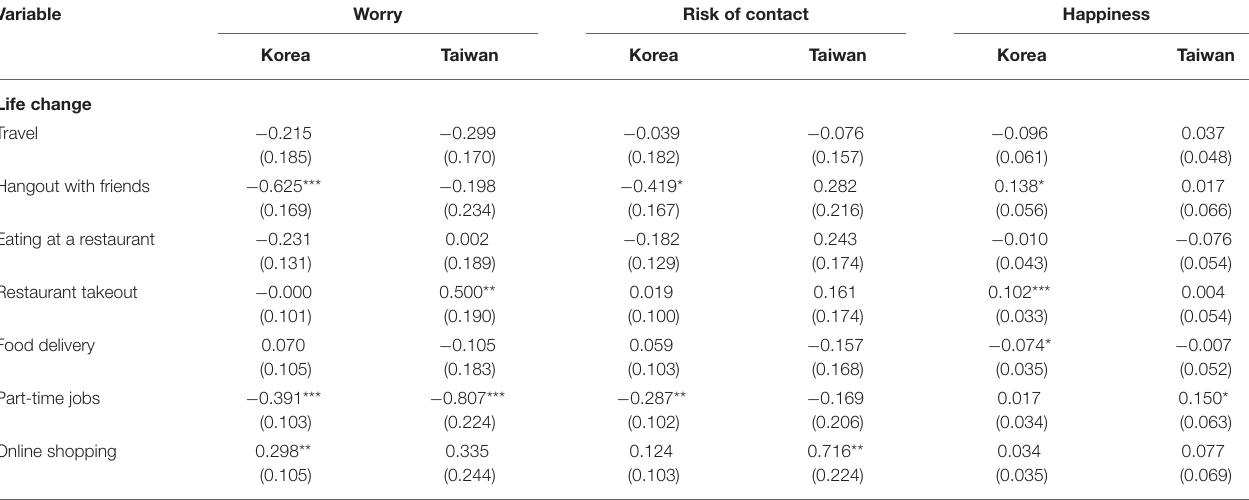
TABLE 2 | Results of multiple regression analyses on three aspects of mental health conditions.